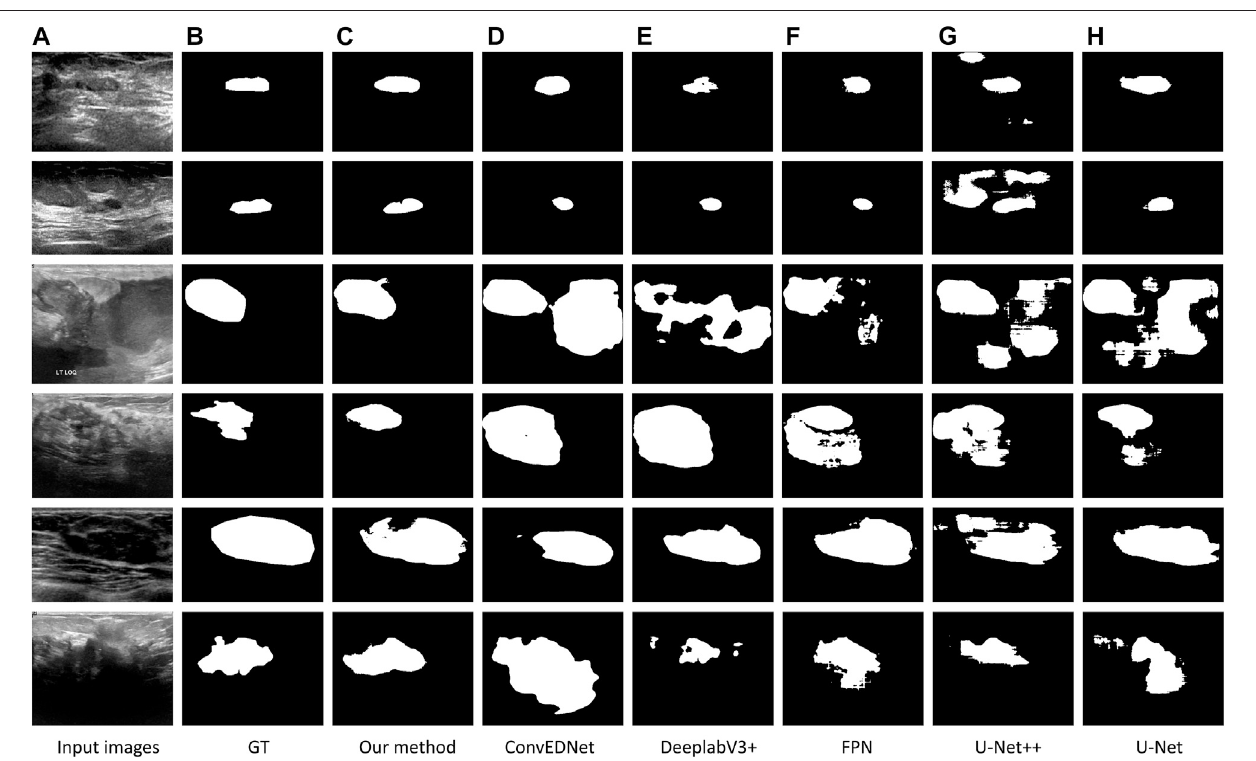
FIGURE 4 | Comparison of breast lesion segmentation among different methods. (A) Testing images. (B) Ground truth (denoted as GT). (C – H) : Segmentation results obtained by our approach (BGM-Net), ConvEDNet Lei et al. (2018), DeeplabV3+ Chen et al. (2018), FPN Lin et al. (2017), U-Net++ Zhou et al. (2018), and U-Net Ronneberger et al. (2015), respectively. Note that the images in fi rst three rows are from BUSZPH, while the images in last three rows are from BUSI.